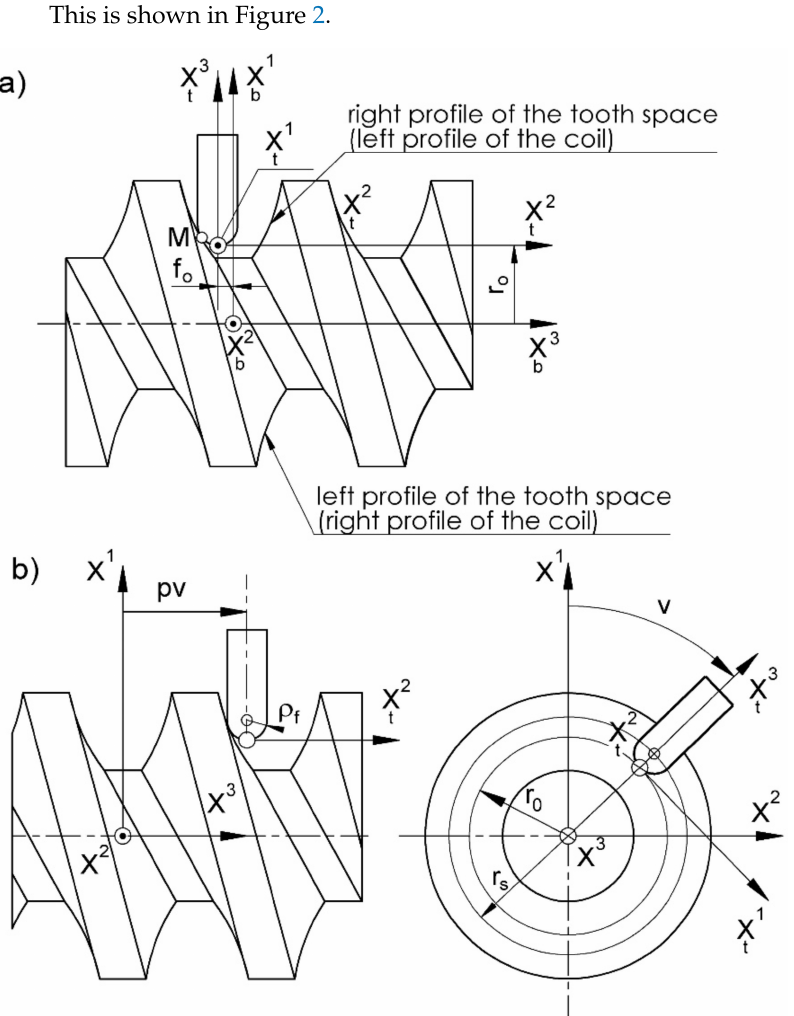
Figure 2. ( a ) Positioning and ( b ) relative helical motion of the mill and machined worm